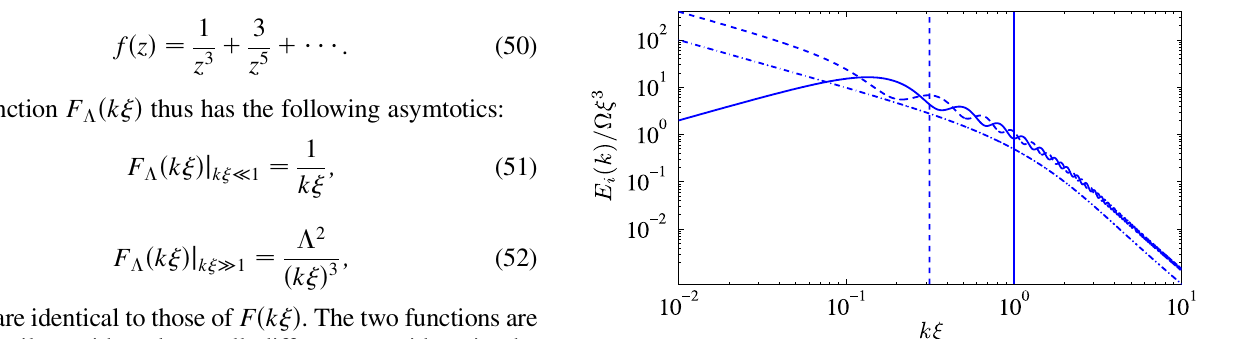
(cid:5) 2 (cid:5)=d is d